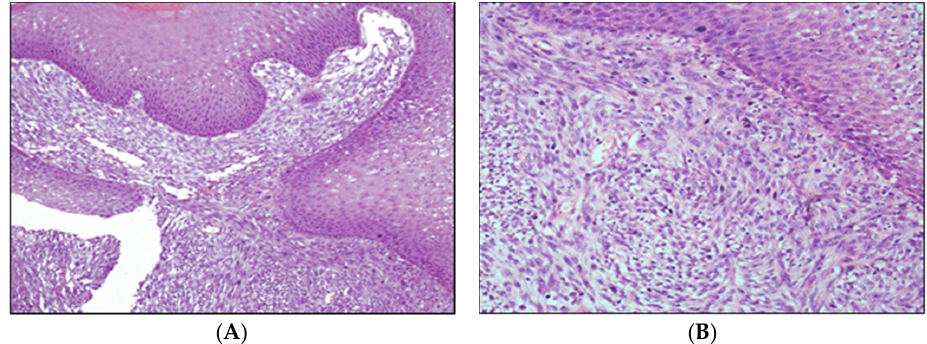
Figure 3. Photomicrograph of oral amelanotic melanoma (( A ), Objective 10 ×; ( B ), Objective 20 ×). Hematoxylin and eosin.